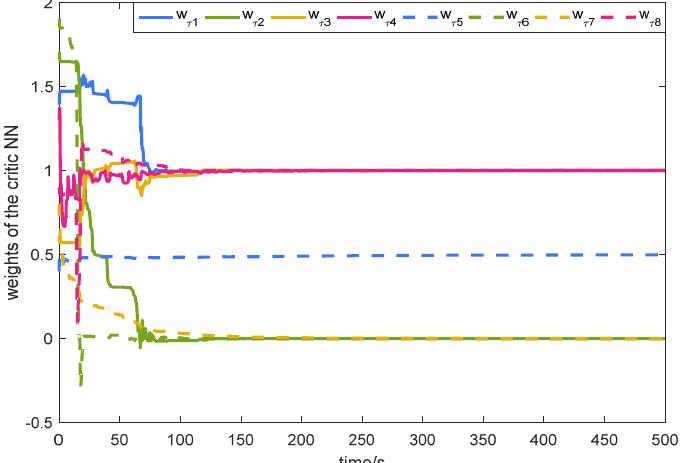
Figure 9. Weights of critic neural network.